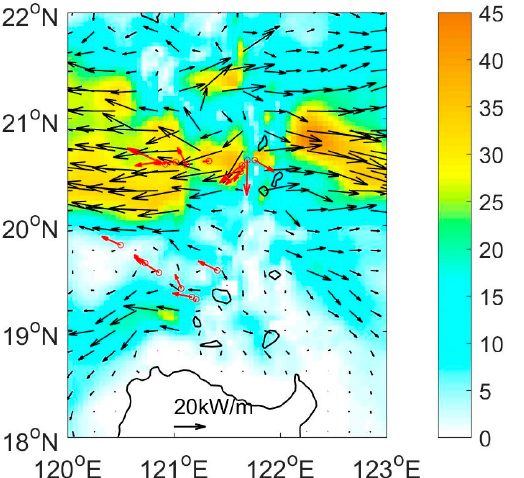
Figure 3. Simulated (black arrows) and observed (red arrows) semidiurnal energy flux at the LS. The magnitude of the energy flux is indicated by shading (unit: kW/m).